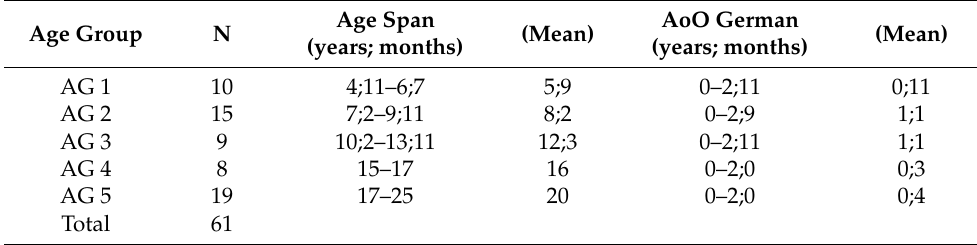
Table 1. Simultaneous bilinguals included in the study.